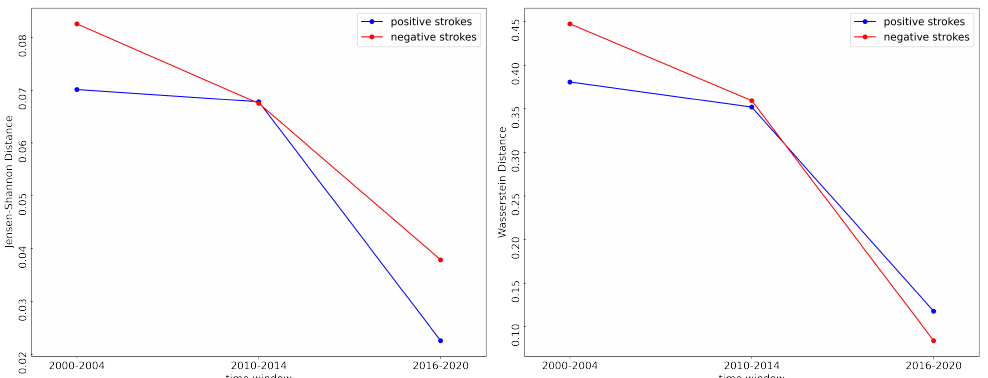
Figure 7. Compliance with Benford’s law for number of positive and negative strokes with current amplitude over 10 kA per day (lower is better). ( Left panel ) Jensen–Shannon distance; ( right panel ) Wasserstein